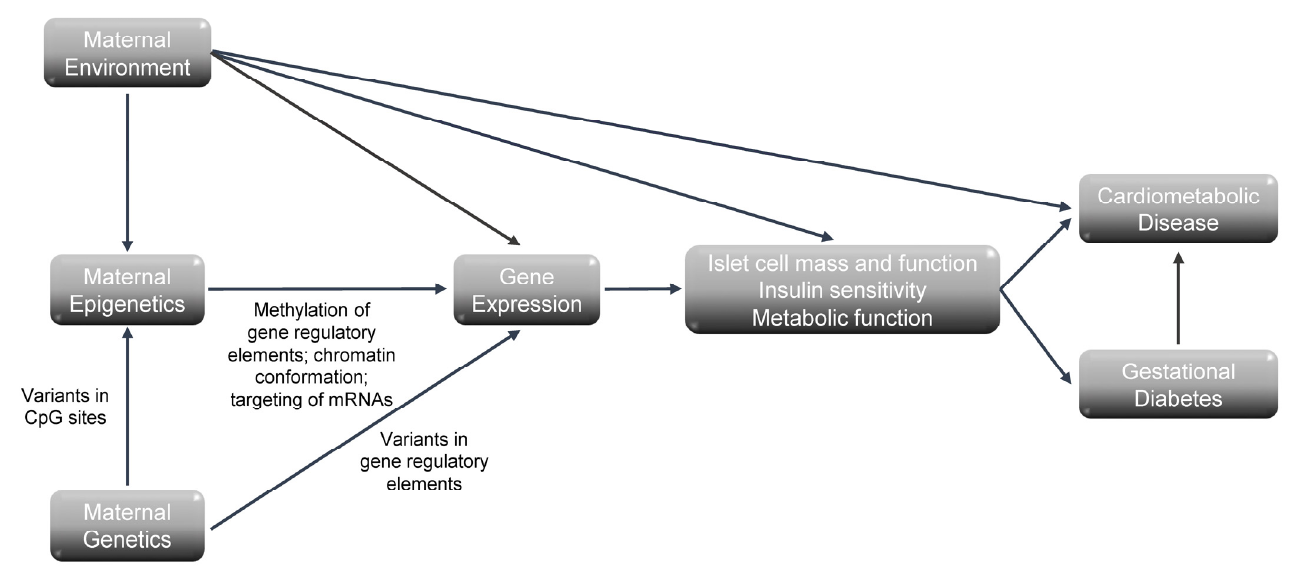
Figure 1. Model for the relationship of maternal genetics, epigenetics, and environment in the risk for gestational diabetes and its long-term cardiometabolic outcomes.